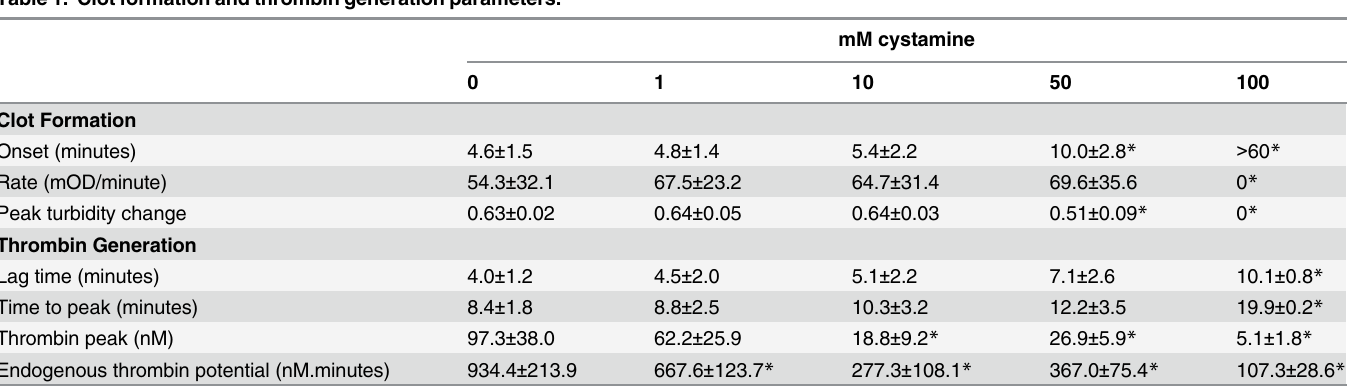
Table 1. Clot formation and thrombin generation